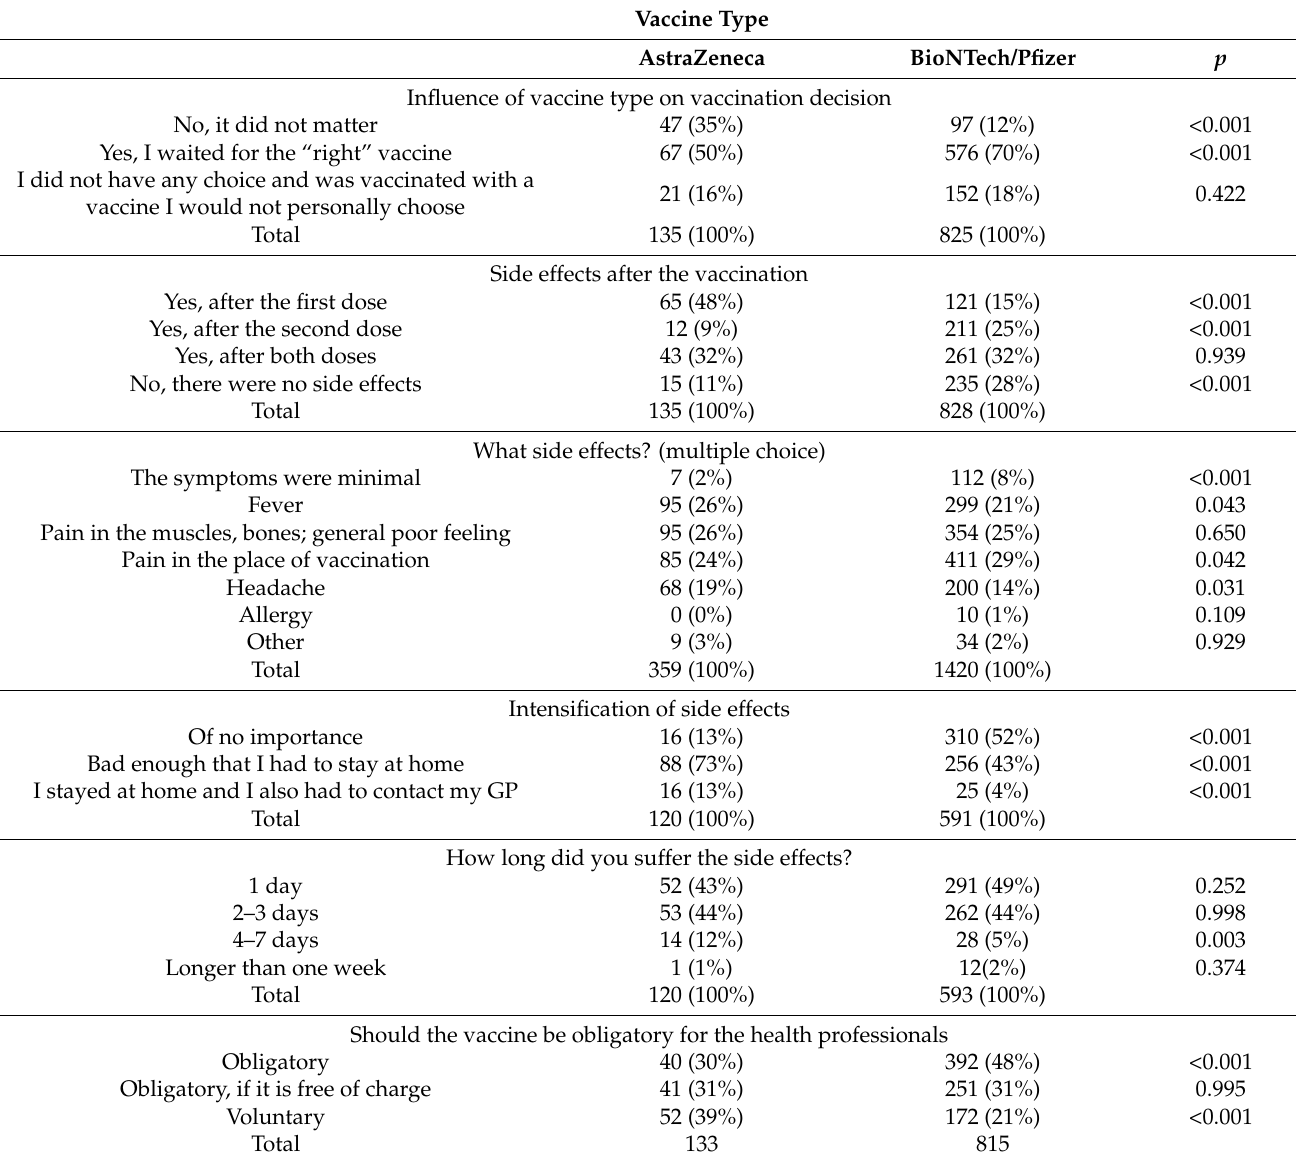
Table 5. Side effects after vaccination against COVID-19 among the vaccinated healthcare